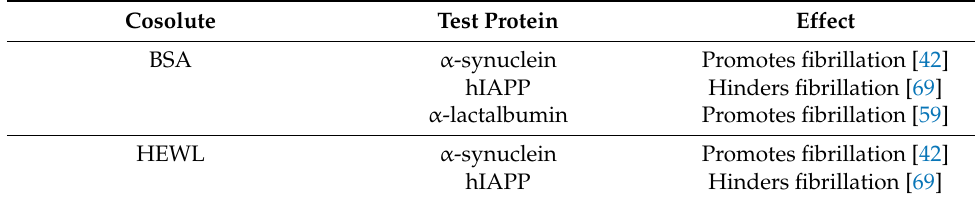
Table 3. Effects of protein crowders on protein